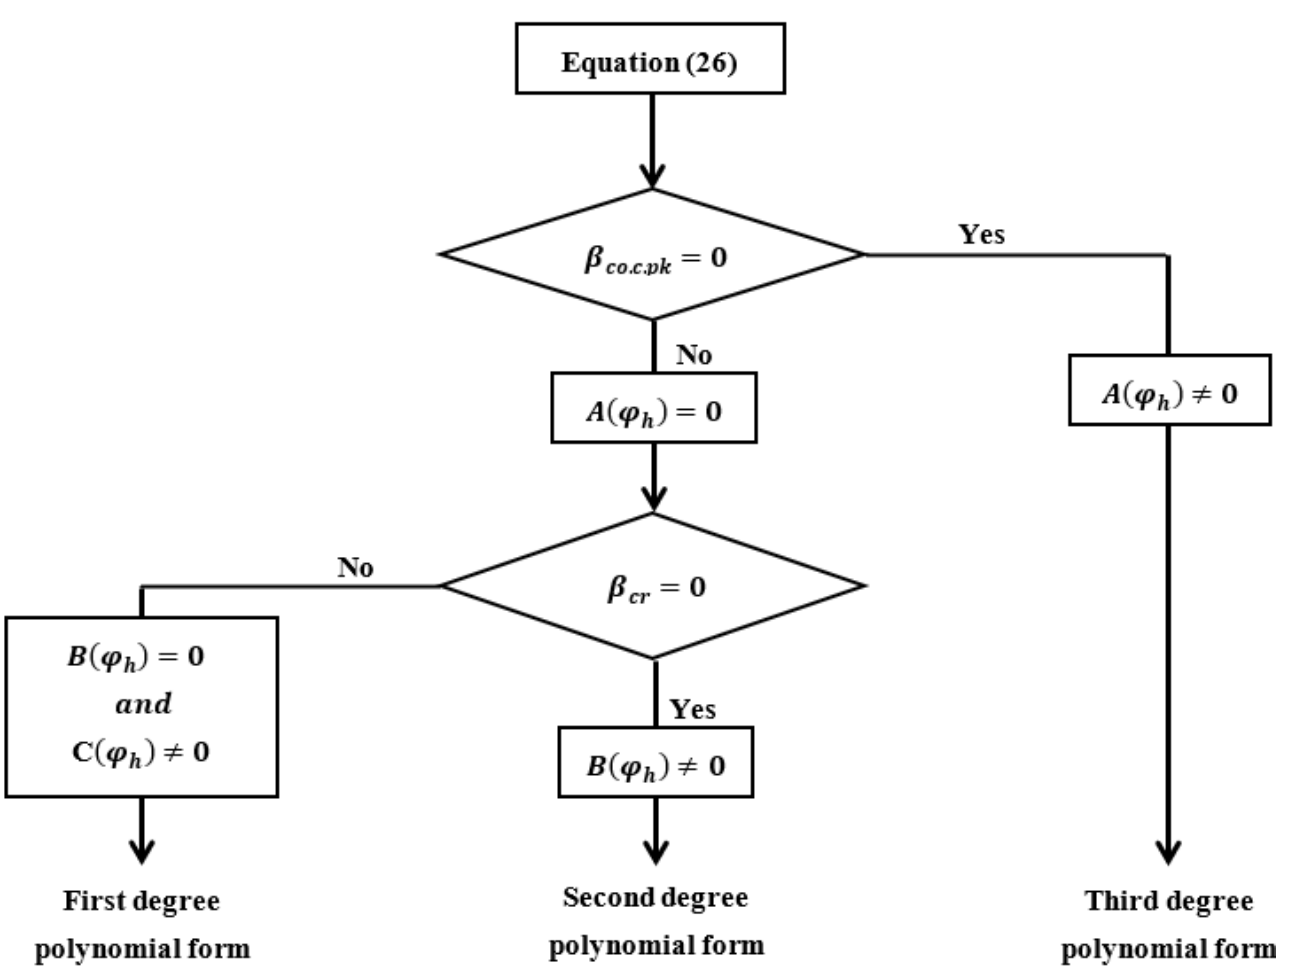
Figure 14. Polynomial forms taken by Equation (26) according to values taken by ( β (cid:2913)(cid:2925).(cid:2913).(cid:2926)(cid:2921) and β (cid:2913)(cid:2928) ).